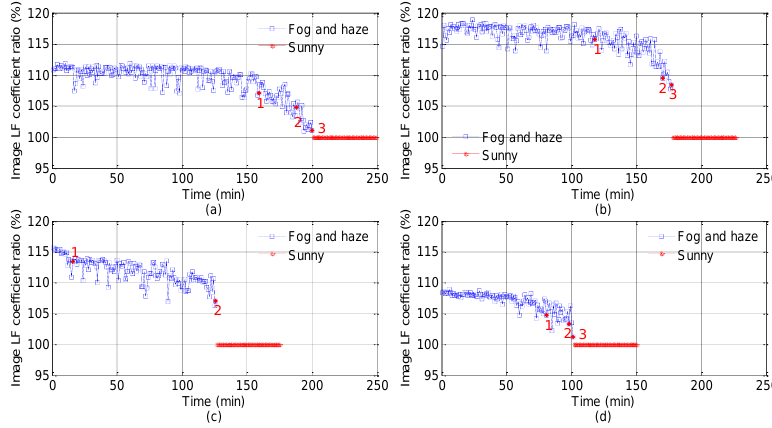
Figure 5. Low frequency coefficient ratios (( F r (0, 0) = F l (0, 0) /F h (0, 0). The red numbers 1, 2 and 3 indicate 100 m, 200 m and 300 m, respectively. The upper limit visibility in road points 5 is 200 m, and so there is no red number 3 in ( c ). The ratio values shown in ( a – d ) are corresponding to the Points 2, 4, 5 and 6, respectively.).